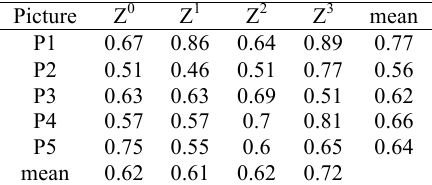
Table 5. Classification accuracies for SVM-MLP method, 5- best features selected using t-statistic.